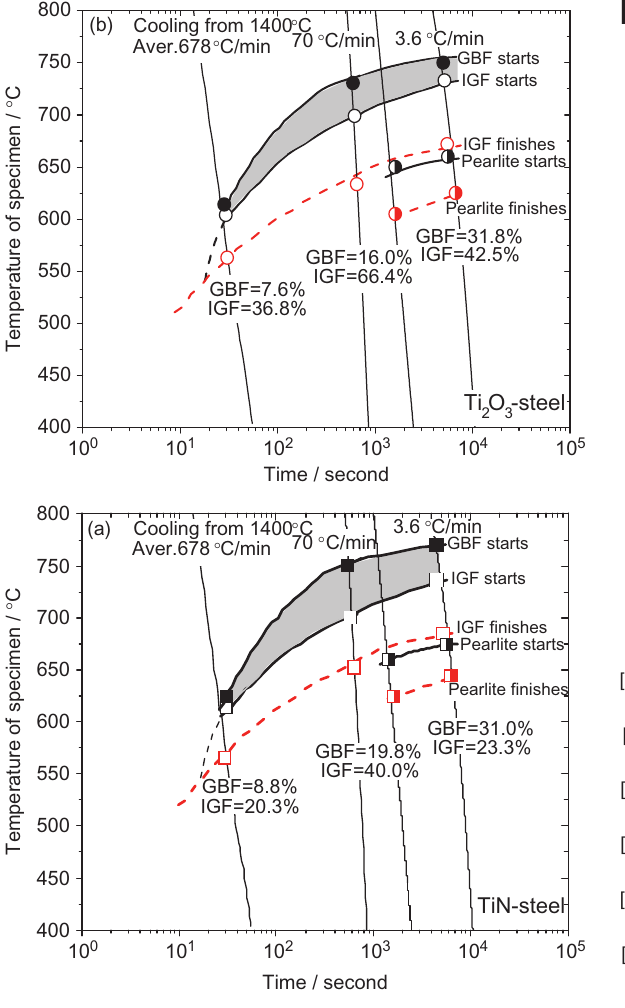
Figure 18: Schematic CCT diagram of austenite decomposition for (a) steel with Ti 2 O 3 addition and (b) steel with TiN addition [12].